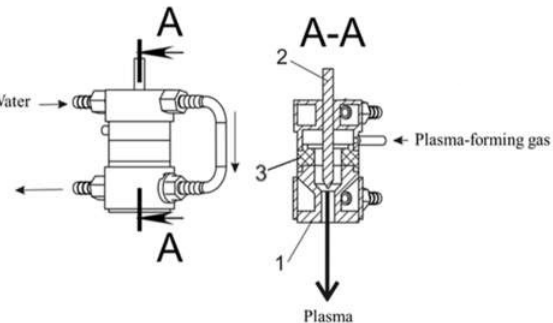
Figure 2. Schematic diagram of the plasmatron; 1—anode, 3—cathode, 3—interelectrode ceramic insert.